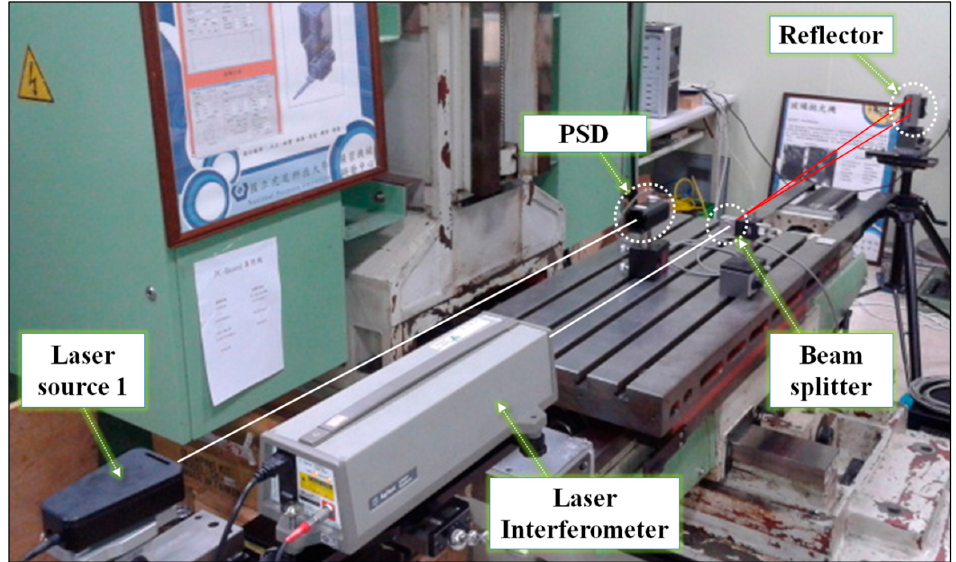
Figure 10. Verification setup of single-axis measurements.